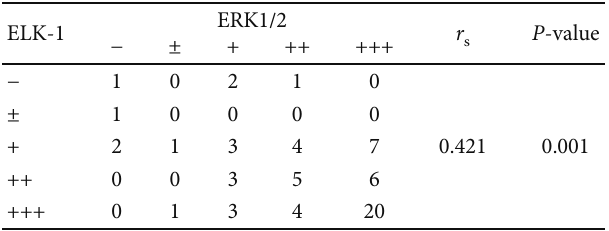
Table 7: The relationship between ERK1/2 and ELK-1 protein expression in colon cancer tissue.